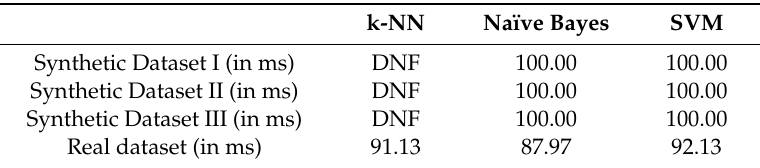
Table 3. Accuracy with Python and R framework.